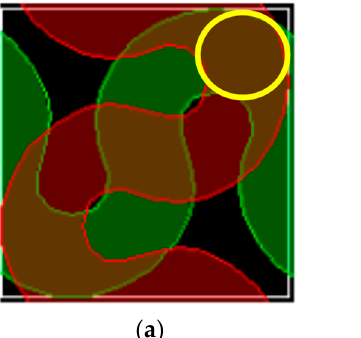
Figure 4. ( a ) Internal structure of a sensing element of the sensor XL S2004. The most active region, where two sensing elements are superimposed, is encircled in yellow; ( b ) External view of the sensor with the most active region encircled in yellow.